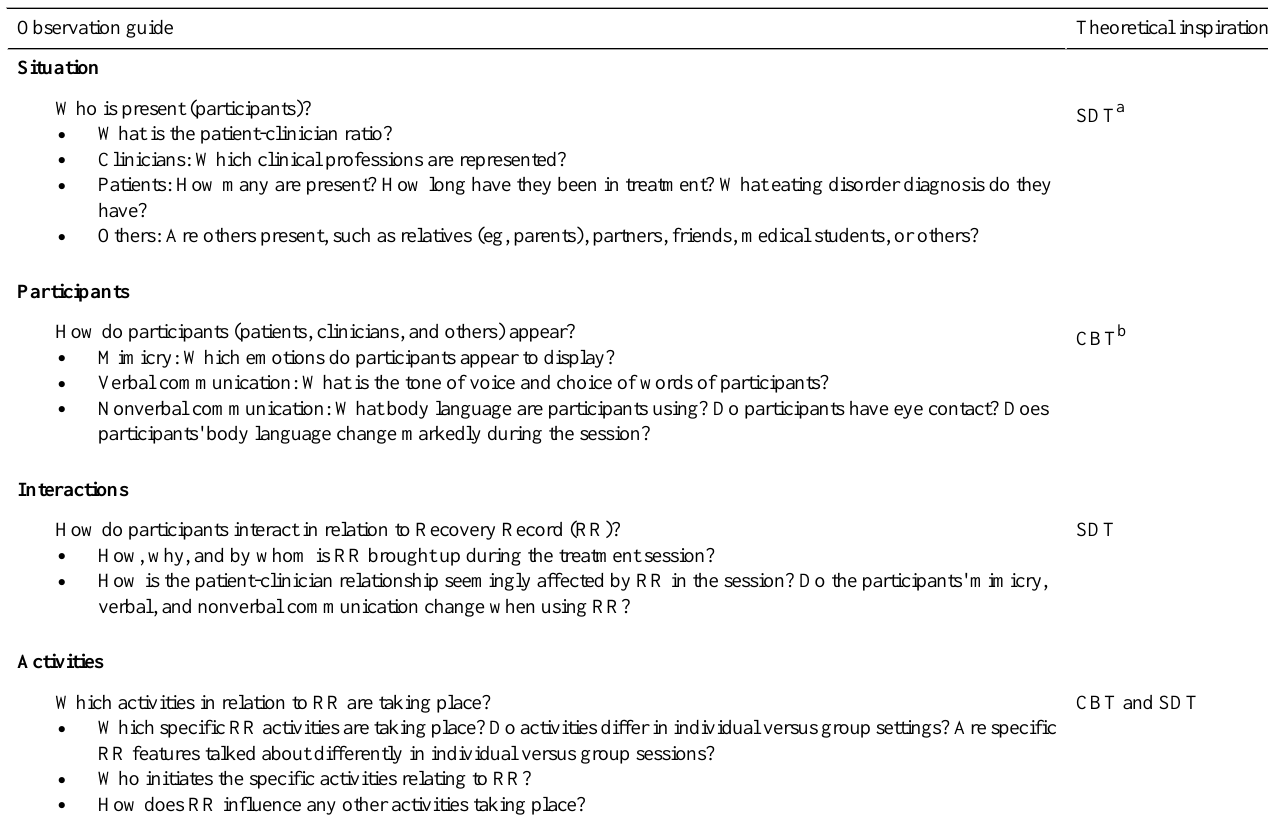
Table 2. Observation guide. Field notes were recorded discretely during or immediately after the observations. The theoretical inspiration column shows which part of the theoretical framework the topics were inspired